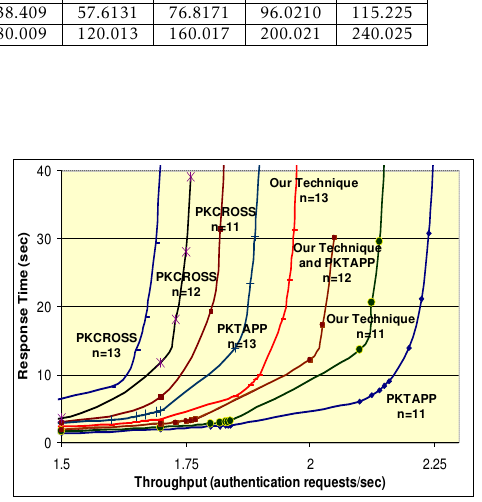
Table 8. The Difference of Transaction Times Between Our Technique and PKCROSS (i.e., g Di ff erence (msec)